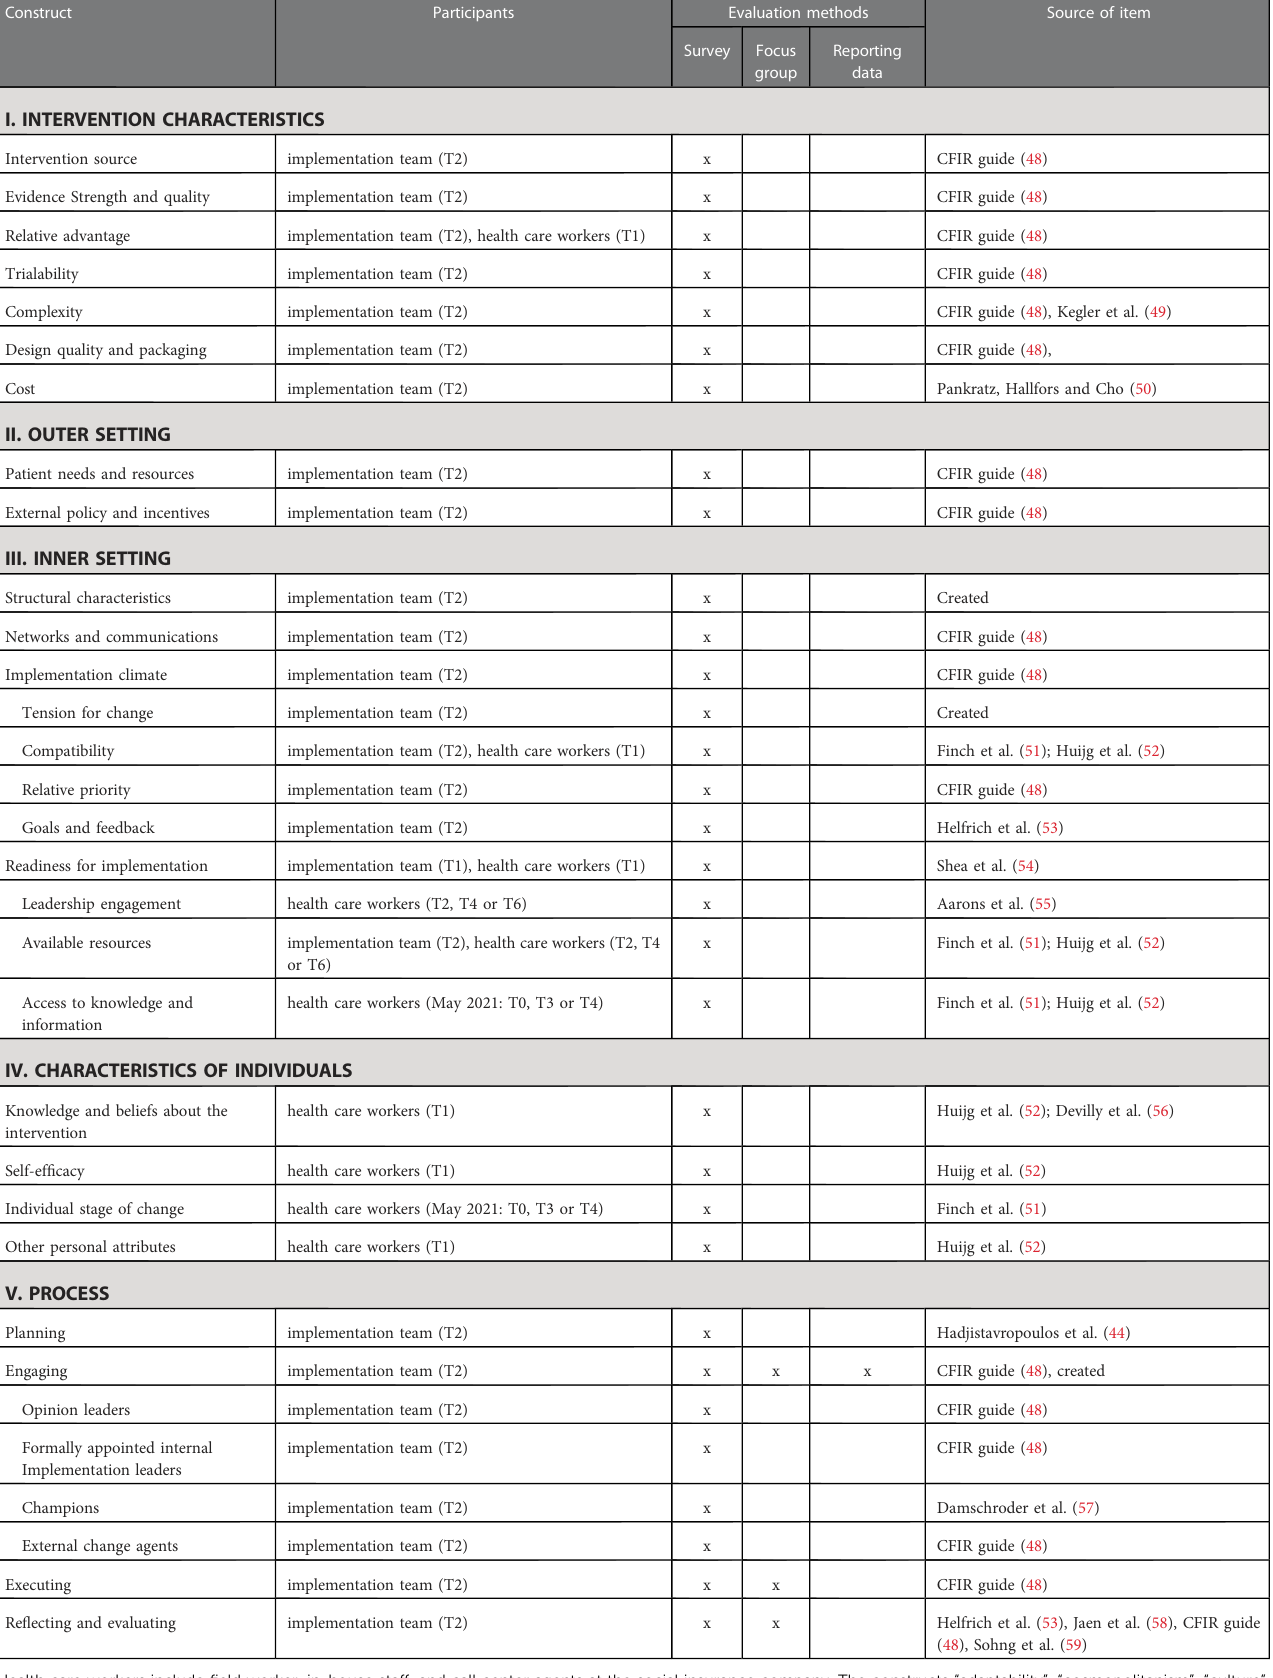
TABLE 2 Overview CFIR domains and selected constructs (30/37), group of participants, evaluation methods and source of